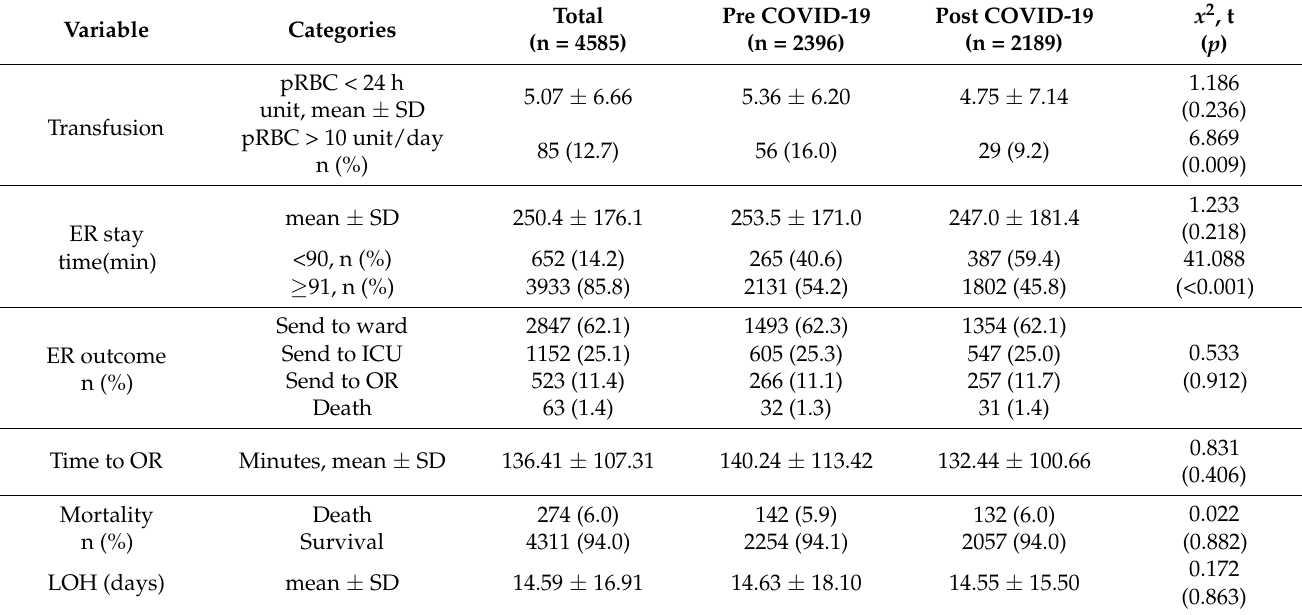
Table 2. Difference between Groups according to Clinical